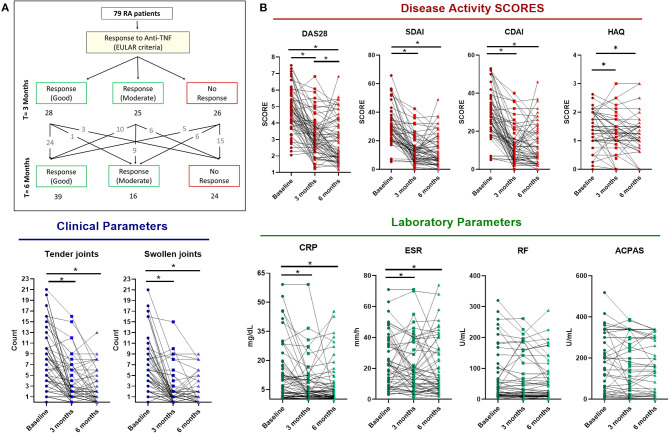
Clinical response to anti-TNF therapy in rheumatoid arthritis patients. (A) Flow diagram representing the clinical response at 3 and 6 months of anti-TNF therapy following EULAR criteria. (B) RA patients' (n = 79) changes in clinical features at 3 and 6 months of anti-TNF therapy including Disease Activity Score (DAS28), Simple Disease Activity index (SDAI), Clinical Disease Activity Index (CDAI), Tender and Swollen Joints, Health Assesment Questionnaire (HAQ), C-reactive protein (CRP), erythrocyte Sedimentation Rate (ESR), Rheumatoid Factor (RF) and Anticitrullinated protein antibodies (ACPAS). *p < 0.05.